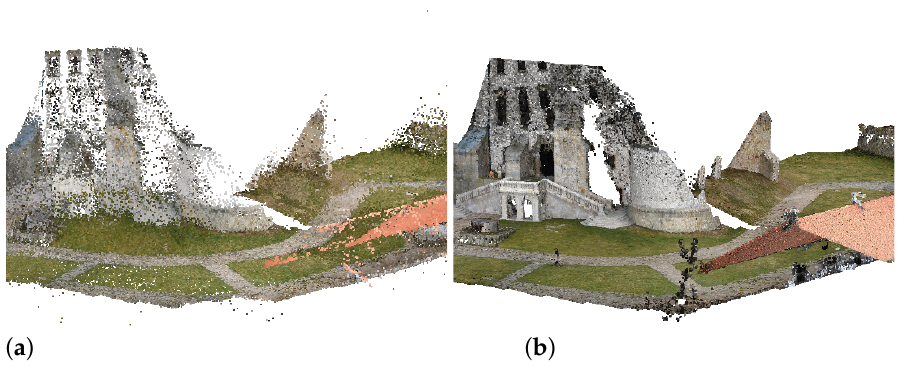
Figure 7. Point cloud density: sparse cloud ( a ), dense cloud ( b ).